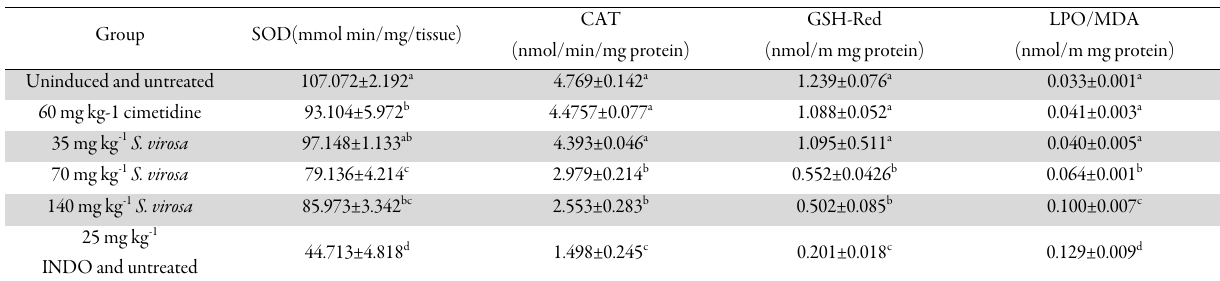
Table 5. Antioxidant enzymes levels and lipid peroxidation in rat stomach tissues Group